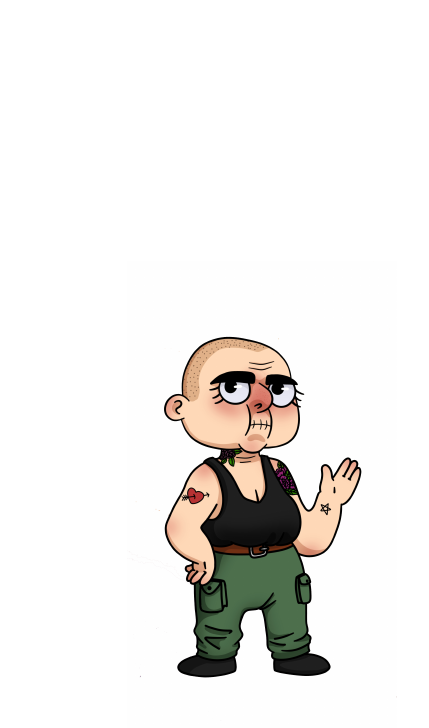
Figure 7. The character of the second phase -